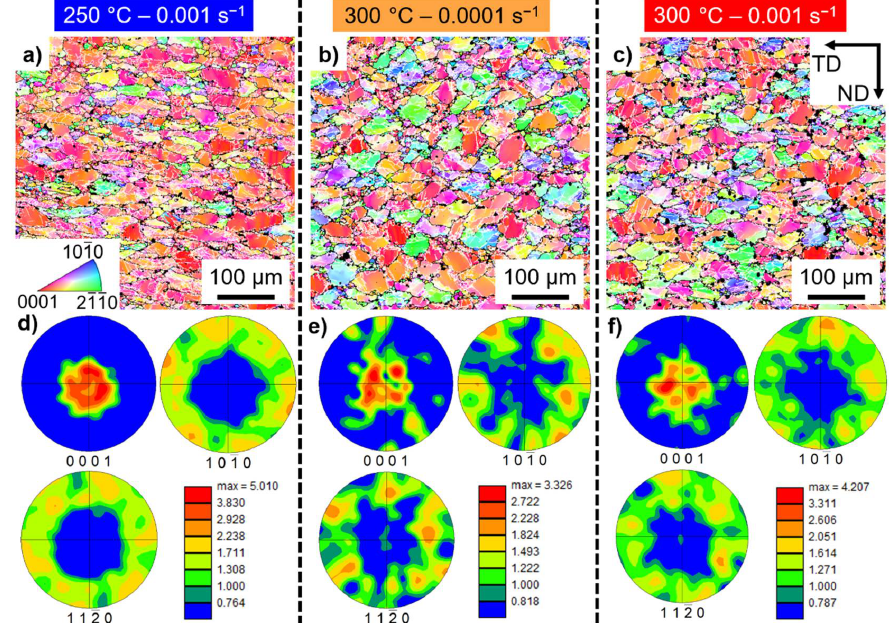
Figure 3. Electron backscattered diffraction results for the ZK40 alloy: ( a – c ) inverse pole figure maps and ( e , f ) pole figures. The tested conditions: ( a , d ) 250 °C and 0.001 s −1 ; ( b , e ) 300 °C and 0.0001 s −1 ; ( c , f ) 300 °C and 0.001 s −1 . Only α-Mg is indexed. Non-indexed regions are highly deformed regions or intermetallic compounds. White and black lines indicate low and high angle grain boundaries, respectively. ND and TD indicate the compression and transversal directions, respectively.